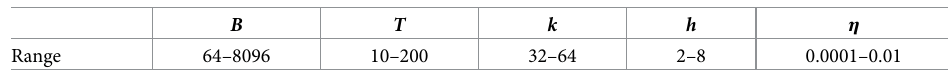
Table 10. Summary of hyperparameter ranges for DNN and